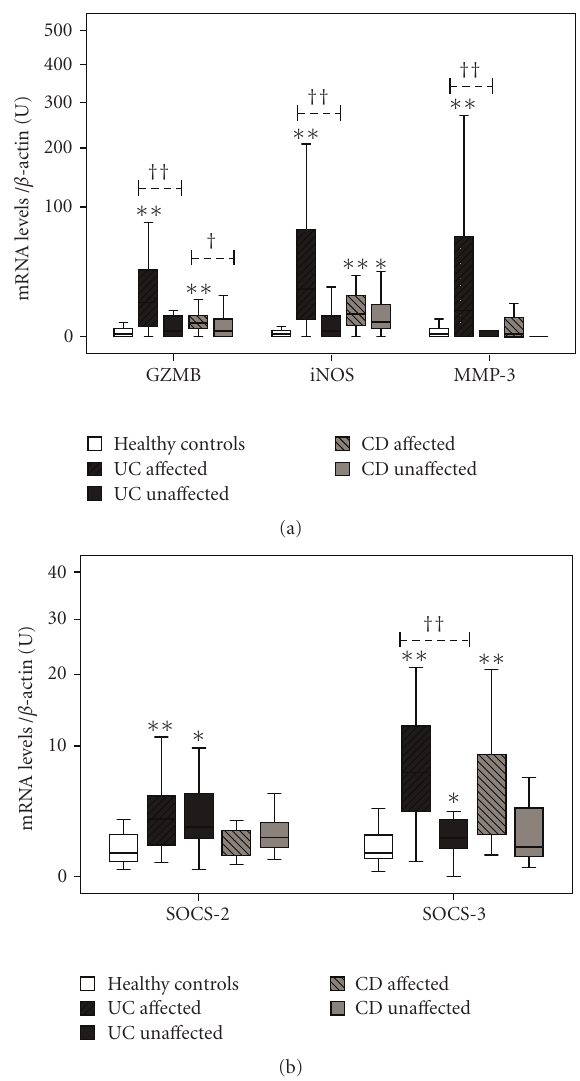
Figure 1: Di ff erences in mRNA levels between study groups, (a) tissue injury-related molecules, (b) SOCS family members. Statistical di ff erences when compared to healthy controls ∗ P < . 05 and ∗∗ P < . 001, and between a ff ected and una ff ected areas from the same pathology †† P < . 001. U: arbitrary